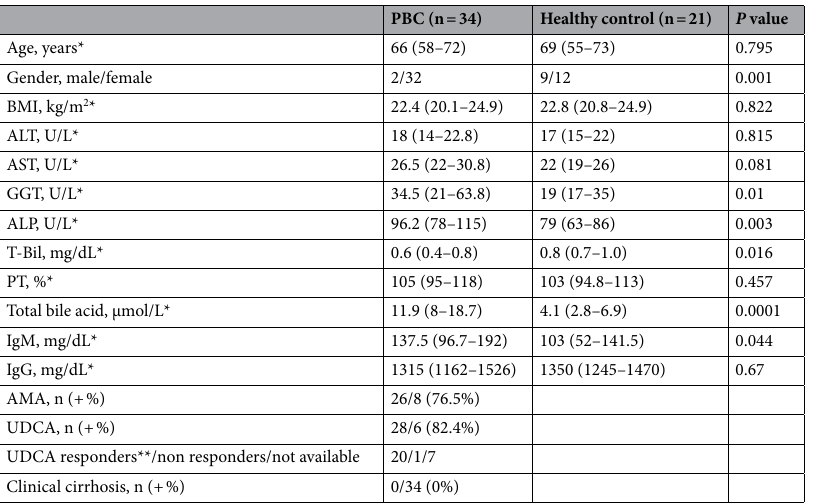
Table 1. Baseline characteristics of 34 patients with PBC and 21 healthy controls. Wilcoxon rank-sum test was used to compare age, BMI, and blood test results between PBC and healthy controls; fisher’s exact test was used to compare gender distribution between PBC and controls. PBC, primary biliary cholangitis; BMI, body mass index; ALT, alanine aminotransferase; AST, aspartate aminotransferase; GGT, γ-glutamyltranspeptidase; ALP, alkaline phosphatase; T-Bil, total bilirubin; PT, prothrombin time; IgM, immunoglobulin M; IgG, immunoglobulin G; AMA, antimitochondria antibody; UDCA, ursodeoxycholic acid. *Median (interquartile range). **UDCA responders were evaluated based on the Paris-II